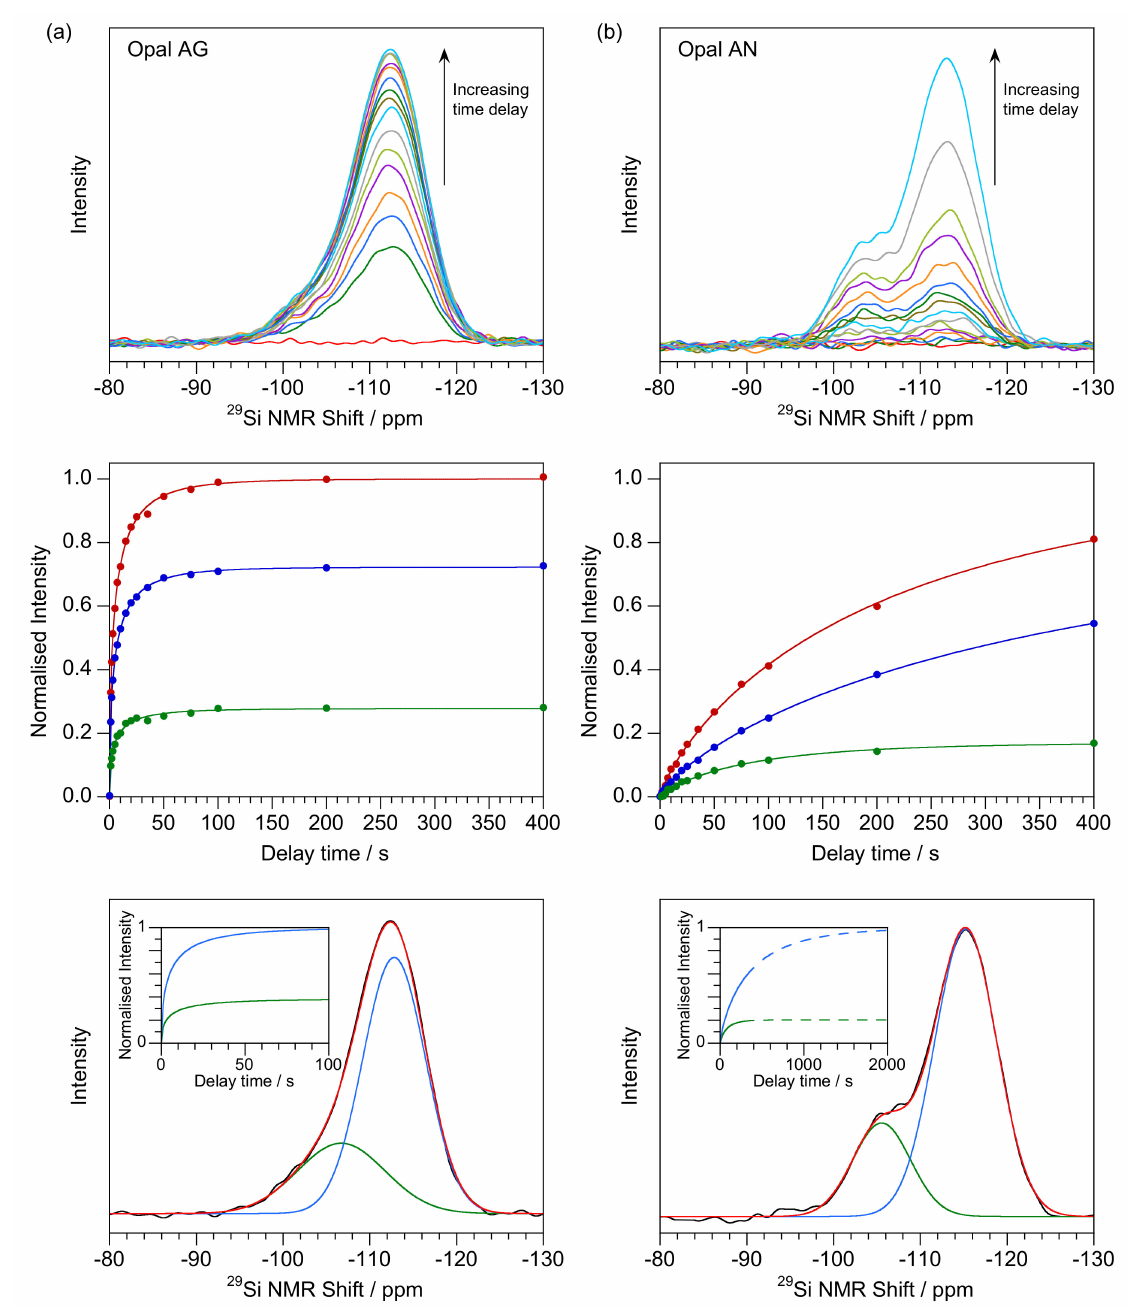
Figure 1. Side by side comparison of ( a ) Opal-AG (G1442 from William Creek, South Australia) with ( b ) Opal-AN (T18117 from North Carolina, USA). Top: spectra after delay times of 1, 2, 3, 5, 7, 10, 15, 20, 25, 35, 50, 75, 100, 200 and 400 s (with the zero-time measurement shown in red). Middle: Time dependence of the total integrated signal (red), and Gaussian-fitted Q 3 (green) and Q 4 (blue) signals. The line of best fit from Weibull fitting is shown as solid line. Intensity is normalized to the fitted A ∞ value of the integrated signal fit. Lower: Gaussian deconvolution of the Q 3 and Q 4 components for the 400 s delay time data as determined from global fit of all delay times. The time behaviour displayed in the inset is generated from the globally fitted λ and κ values and normalized to the Q 4 A ∞ value. Extrapolated data to longer times is shown by a dashed